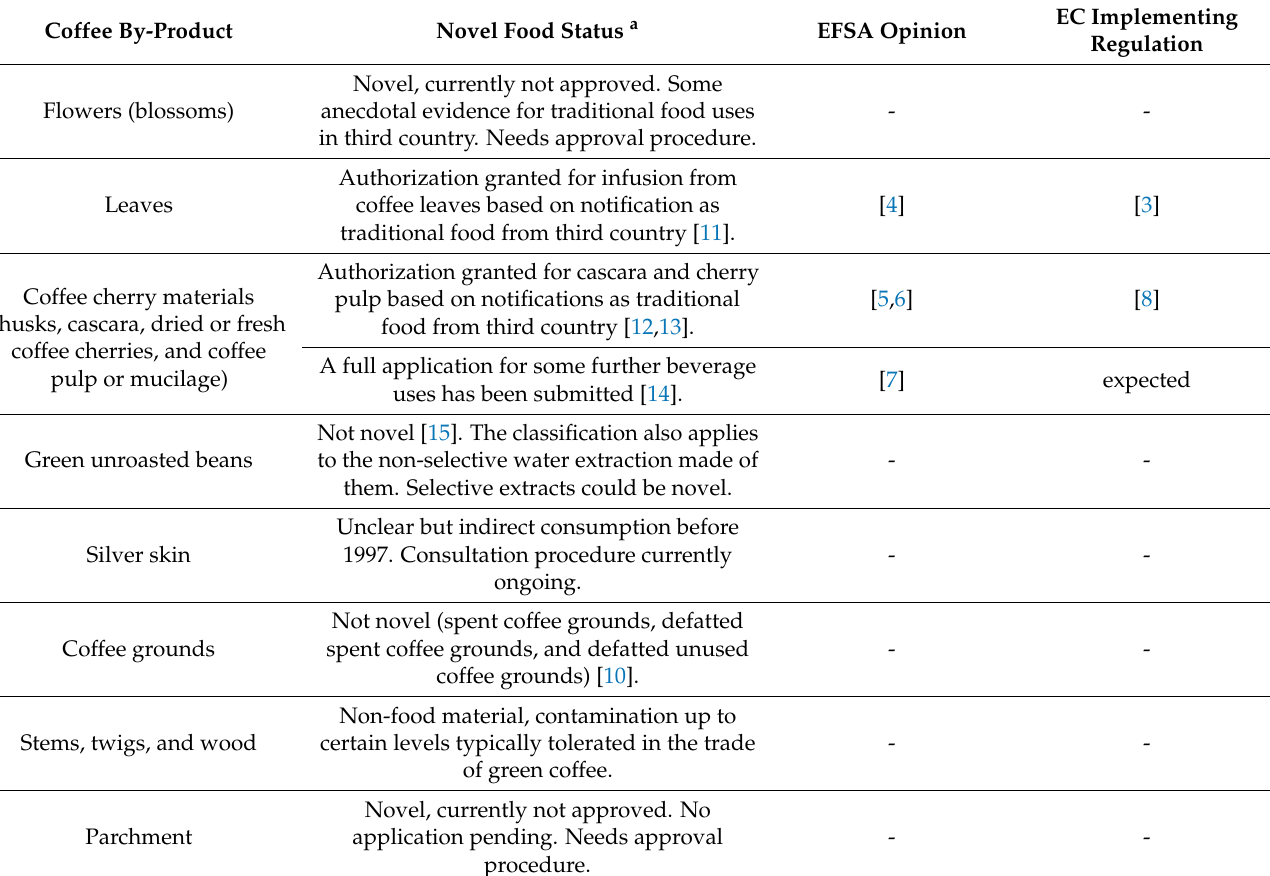
Table 1. Coffee by-products and assessment of their novel food status considering Regulation